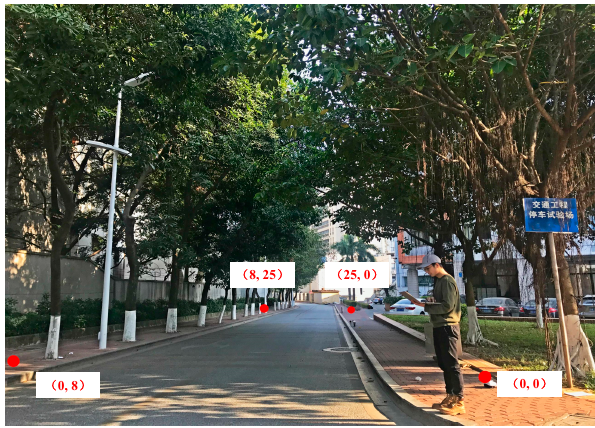
Figure 3. Experiment